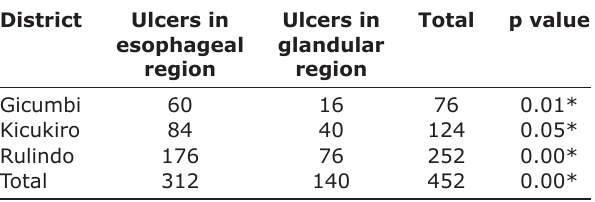
Table-4: Occurrence of esophageal and glandular gastric ulcers in slaughtered male pigs according to district.